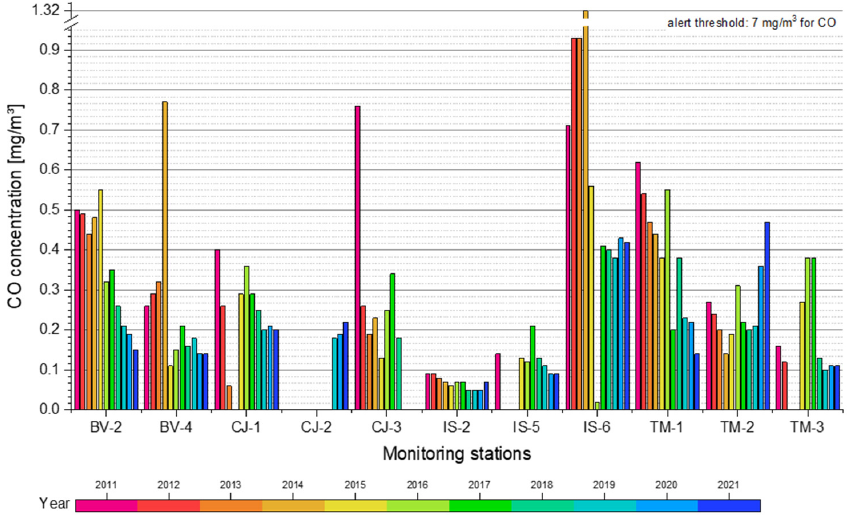
Figure 3. Average annual concentration of CO in the four cities (Brasov, Cluj-Napoca, Iasi, and Timisoara).